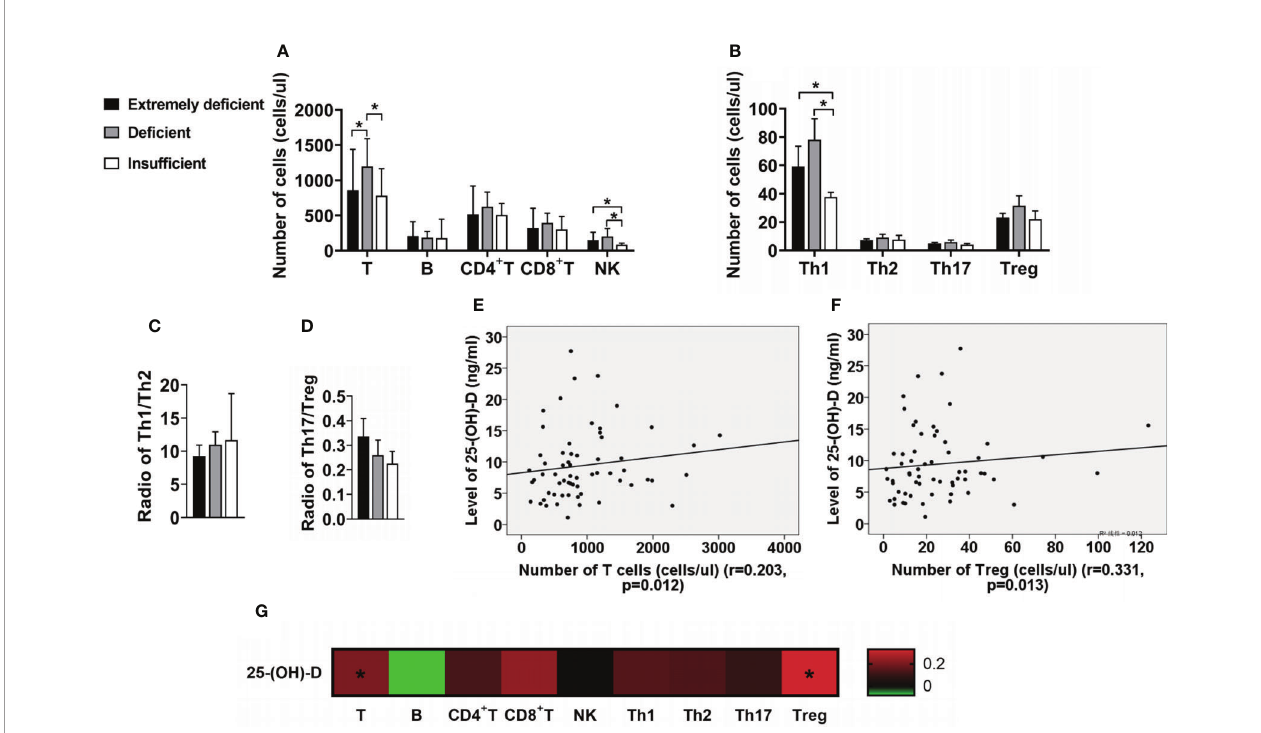
FIGURE 4 | The changes of lymphocyte subsets in IIM patients with different vitamin D levels. (A) Numbers of T, B, CD4+T, CD8+T and NK cells. (B) Numbers of Th1, Th2, Th17 and Treg cells. (C, D) Radio of Th1/Th2 and Th17/Treg. (E, F) The serum 25-(OH)-D levels were positively associated with total T and Treg cells. (G) The associations of the levels of 25-(OH)-D with lymphocyte subsets in IIM patients. *p <